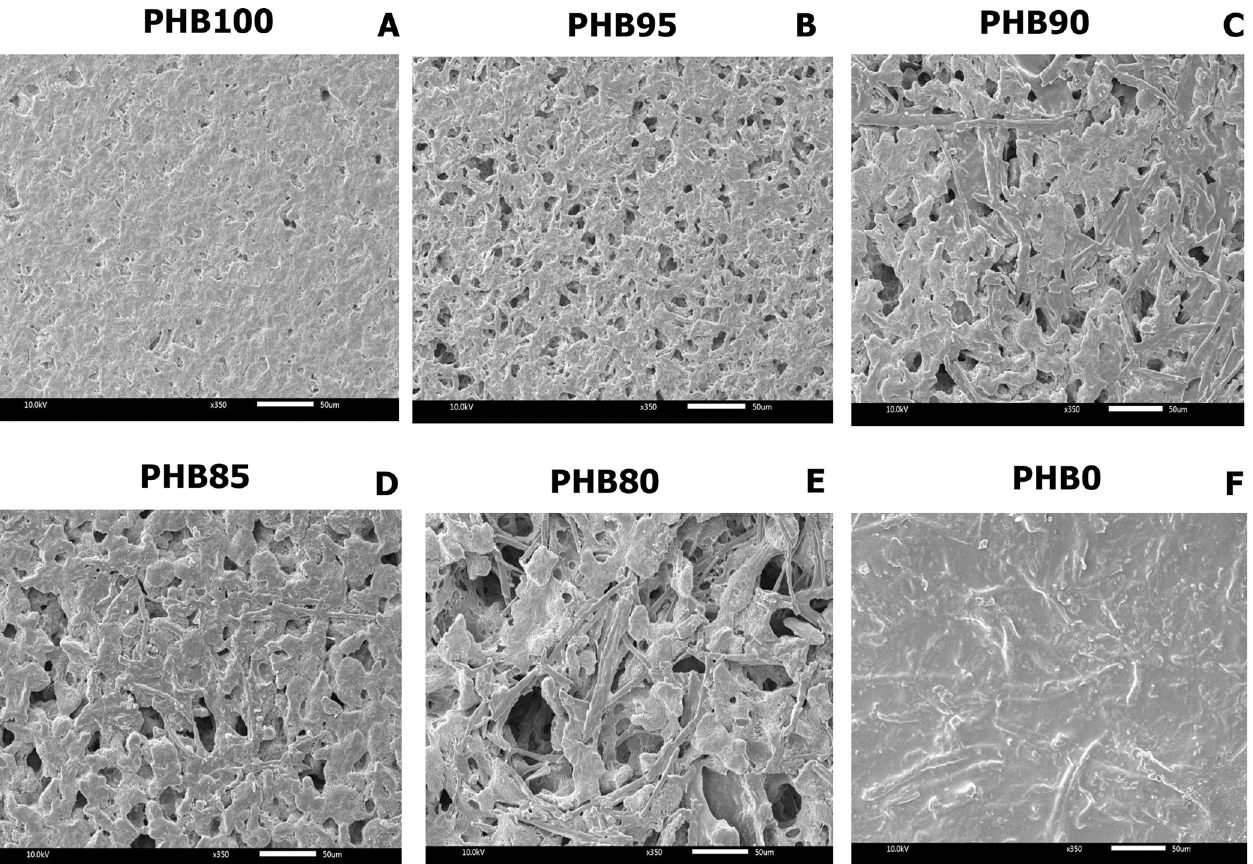
Fig 8. SEM micrographs of the surface morphology of PHB/esterified PALF-MCC laurate biocomposite films.